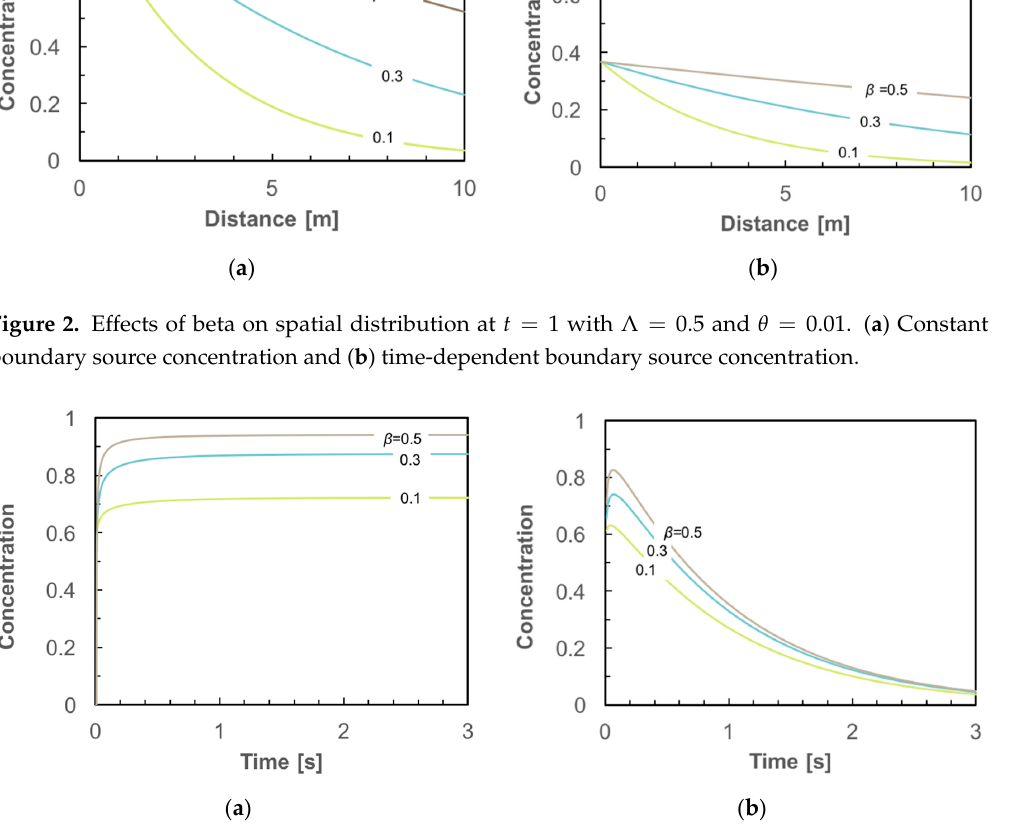
Figure 3. Effects of beta on time history at x = 1 with Λ = 0.5 and θ = 0.01. ( a ) Constant boundary source concentration and ( b ) time-dependent boundary source